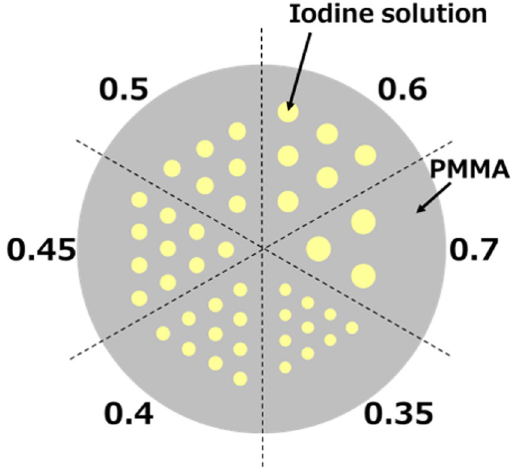
Figure 6. Physical phantom for spatial resolution evaluation (Phantom (III)), consisting of a 10-mm-diameter acrylic cylinder and seven channels of different diameters filled with I solution.